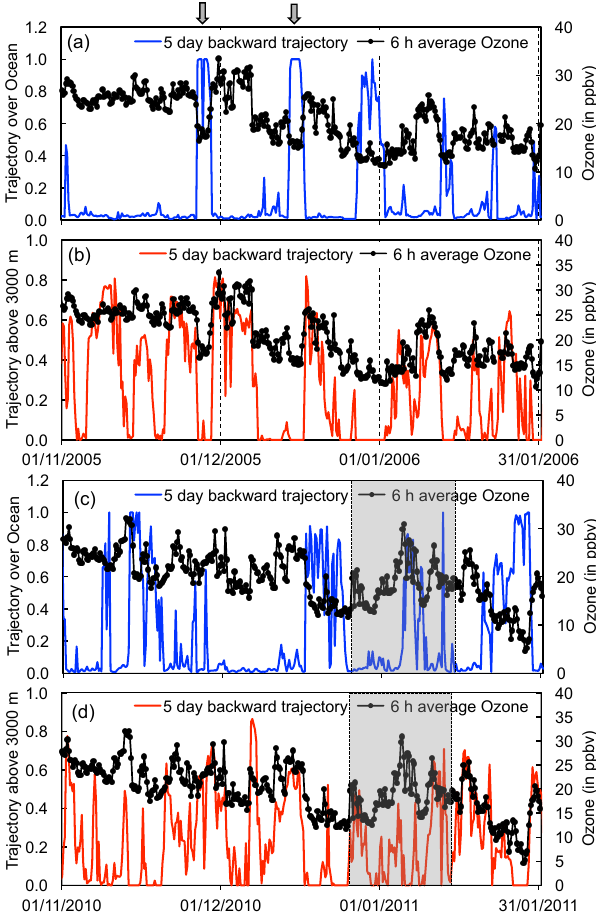
Figure 11. The 6h averaged ozone mixing ratio (black dots) and the corresponding 5-day backward trajectory at DDU from spring 2005 to fall 2006 (a, b) and from spring 2011 to fall 2012 (c, d) . The red and blue lines are the continental (above 3000ma.s.l.) and marine residence time fractions of air masses arriving at DDU as deduced from the HYSPLIT model. The two grey arrows on panel a refer to the days 27–29 November and 14–17 December during which the observed fast decreases of ozone are discussed in Sect. 3.2. The time fractions are averages for the three different arrival heights. The grey area denotes the sampling time period of the OPALE cam- paign.